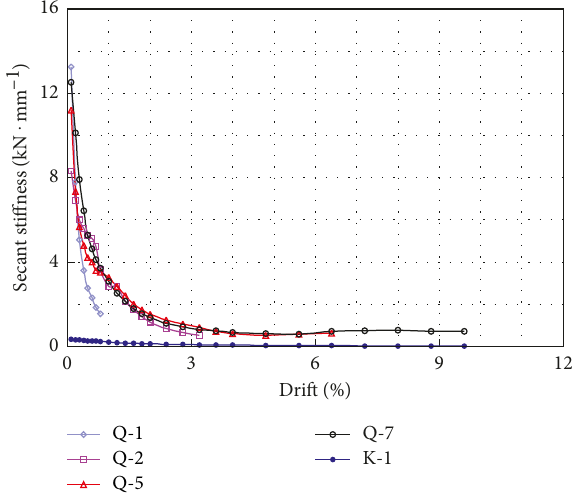
Figure 11: Stiffness degeneration